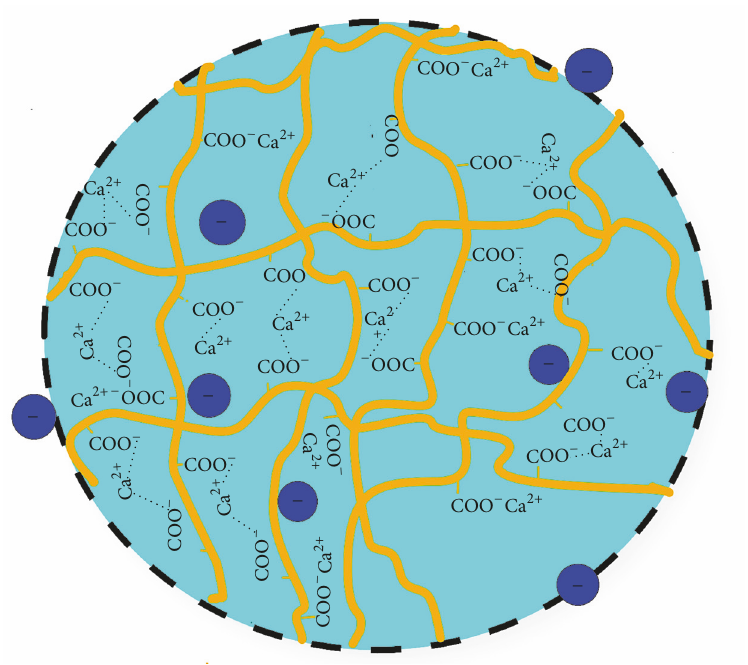
Figure 3: Ionically cross-linked gellan matrix containing yeast cells into the